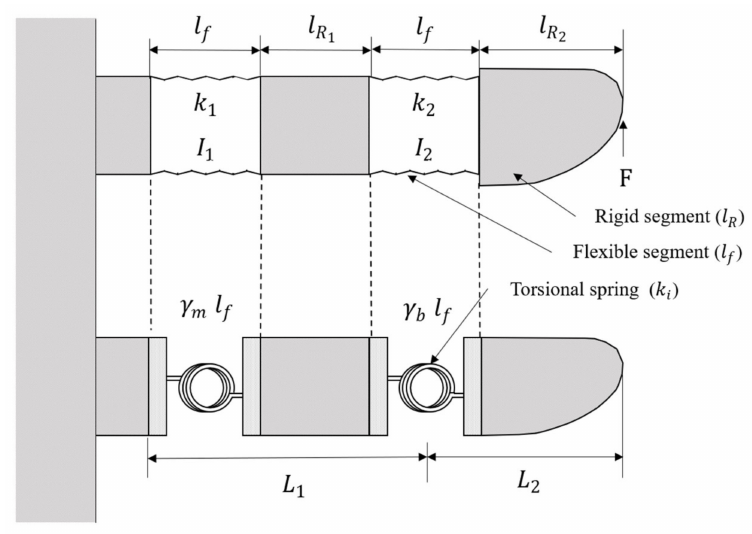
Figure 10. Pseudo-rigid-body model of the variable-stiffness